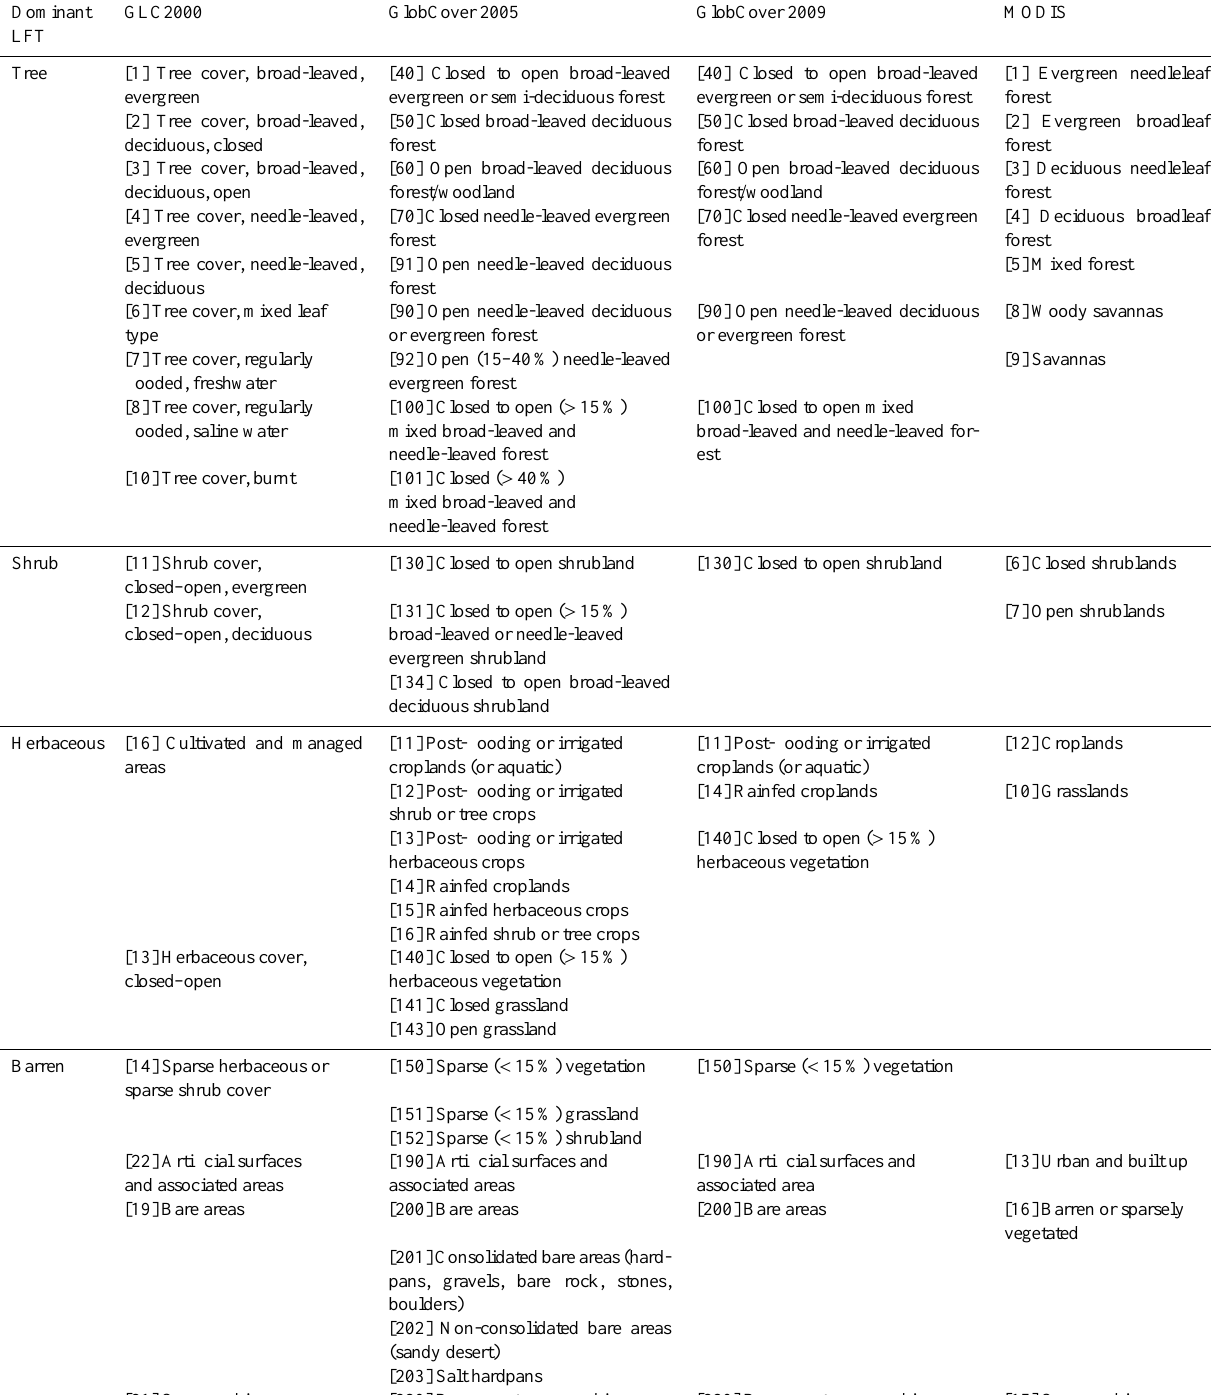
Table 2. Aligning the legends of global maps: dominant life-form type (LFT) and corresponding land cover classes from GLC 2000, GlobCover and MODIS